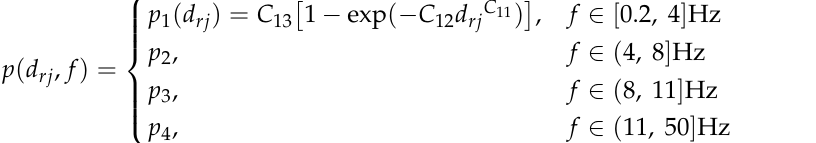
C 11 , C 12 , and C 13 are parameters that depend on the separation distance d rj ; p 2 , p 3 , and p 4 are the mean values of σ ( D F ) / W ( U r ) in the corresponding frequency range.